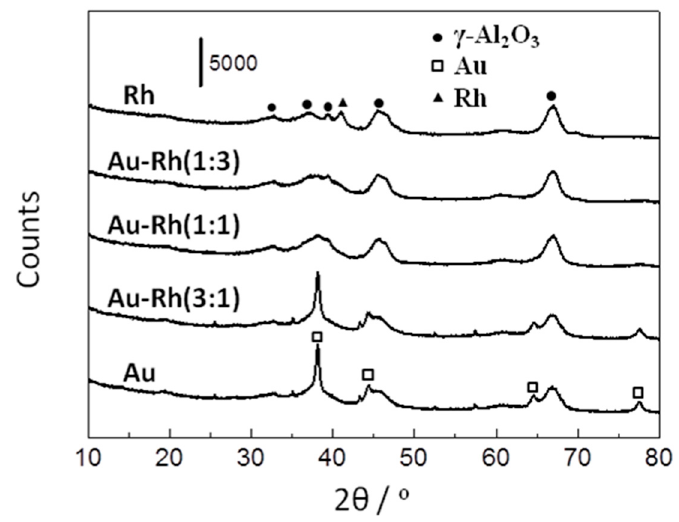
Figure 1. XRD patterns of Au / Al 2 O 3 , Rh / Al 2 O 3 , and AuRh / Al 2 O 3 catalysts with specified molar ratios of Au:Rh.